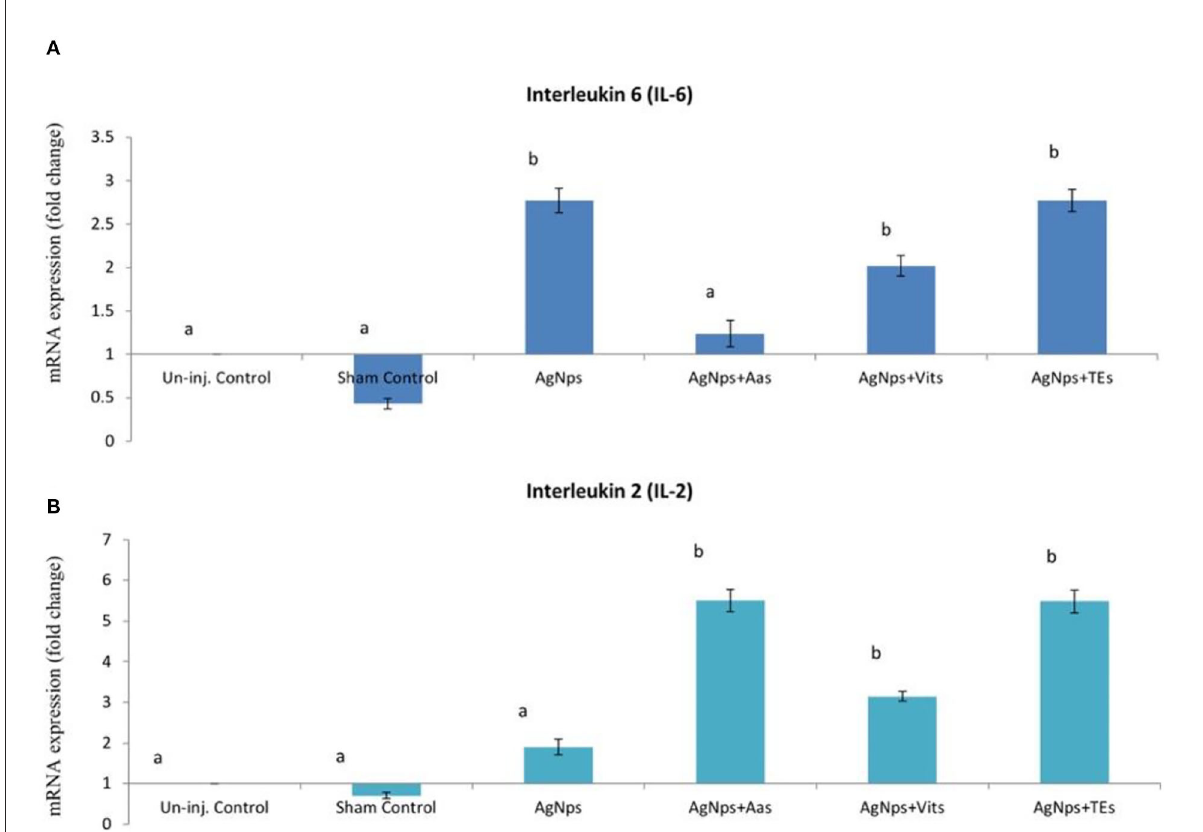
FIGURE4 Effect of in ovo administration of silver nanoparticles (AgNPs) and critical nutrients on the relative expression of IL-6 (A) and IL-2 (B) genes 24h post-virulent ND virus (vNDV) challenge. Control = un-injected, sham (sterile water), AgNPs = silver nanoparticles (50 µ g), AgNPs + AAs = silver nanoparticles (50 µ g) + amino acids (Methionine- 10mg + Arginine-25mg), AgNPs + Vits = silver nanoparticles (50 µ g) + vitamins (Vit B1-72 µ g + Vit B6-140 µ g) and AgNPs + TEs = silver nanoparticles (50 µ g) + minerals (Zn-80 µ g and Se-0.3 µ g). a,b Means bearing different alphabets in a histogram differ significantly ( P <